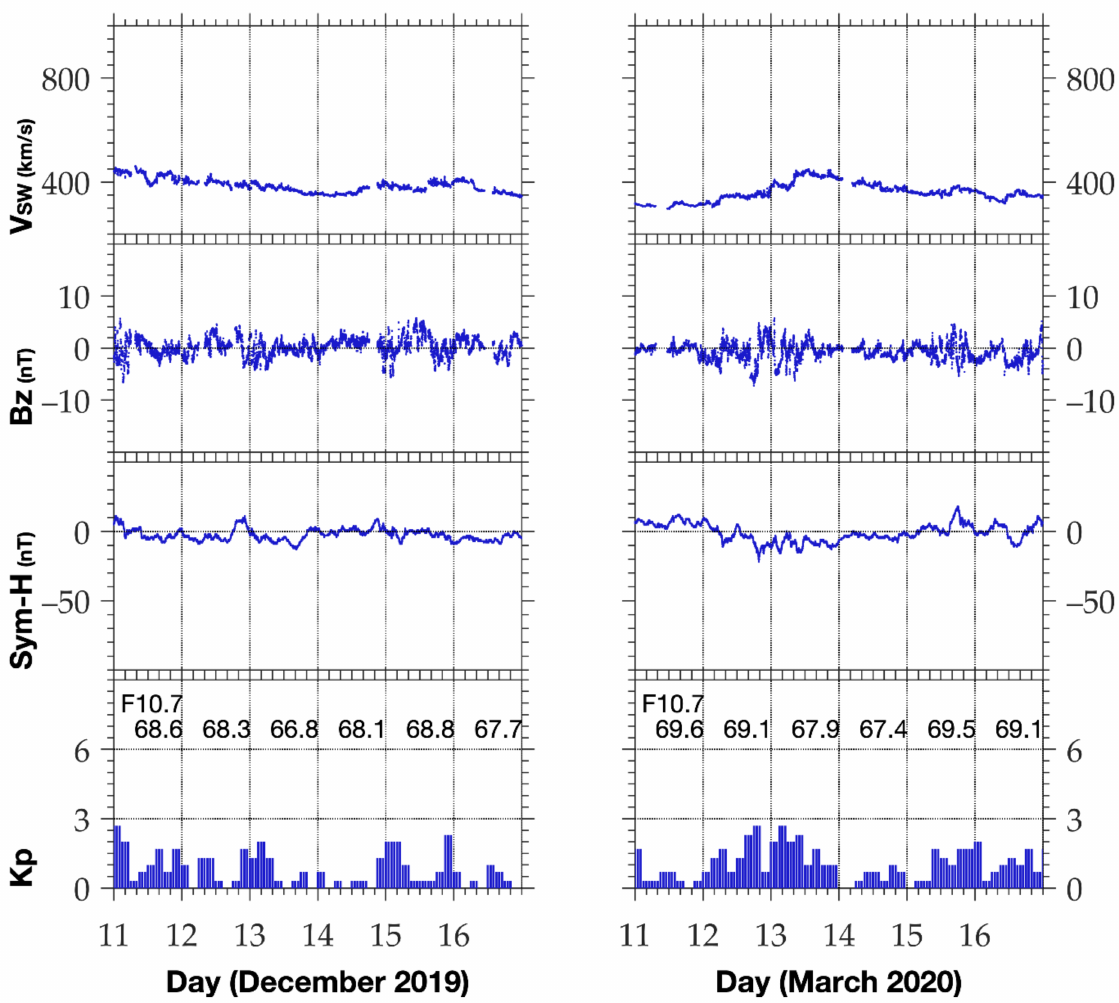
Figure 8. Solar 10.7 cm radio flux (F10.7), solar wind velocity (Vsw), interplanetary magnetic field z component (Bz), and symmetrical H (Sym-H) and Kp indices during 11–16 December 2019 and 11–16 March